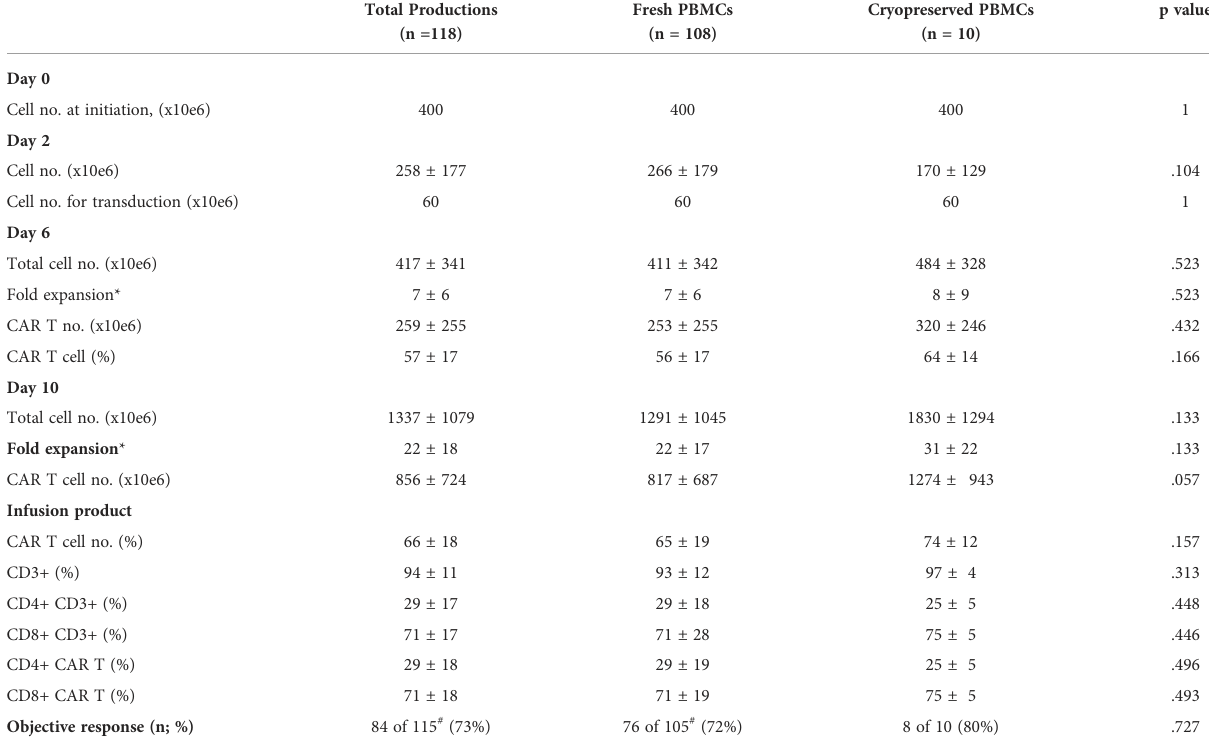
TABLE 1 Production and infusion characteristics of CAR T derived from fresh and frozen